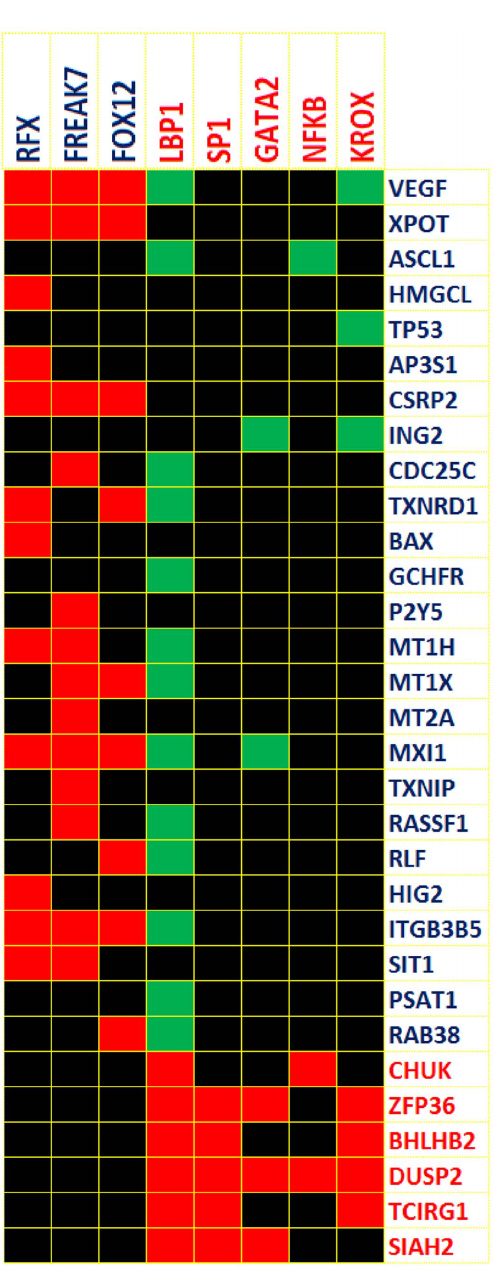
Figure 6. Transcription factor analysis of uniquely activated genes in control and SLE patient samples. The transcription factors tested are shown at the top of the figure. Blue text represents unique genes identified in control samples; while red text identifies unique genes identified in SLE patient samples. Individual elements of the matrix are colored by the significance of the p-values (threshold p=0.05): over-representation in the matrix is indicated in red, under- representation is indicated in